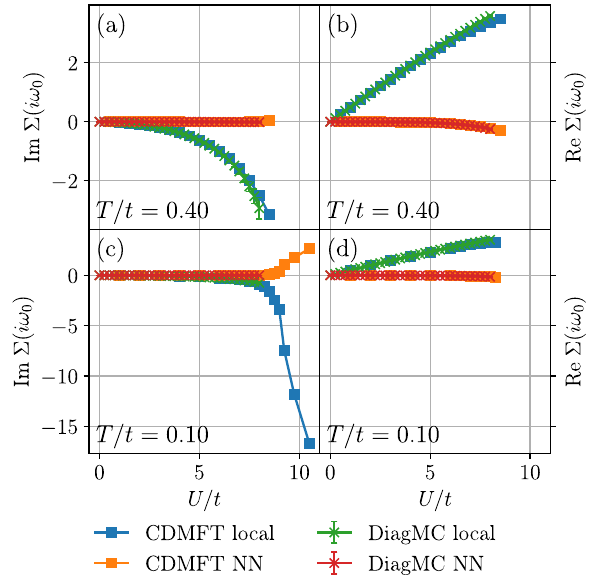
results.FIG. 4. Imaginary (a,c) and real (b,d) parts of the local (blue) and nearest-neighbor (orange) self-energy at its lowest Matsubara frequency calculated by DiagMC (crosses) and CDMFT (squares) as a function of U=t for two different temperatures T=t ¼ 0 . 4 (a,b) and T=t ¼ 0 . 1 (c,d). A substantial increase of nonlocal correlations is observed at low temperatures, however, at interactions ( U=t ≈ 9 . 25 ) larger than the one of increased local correlations ( U=t ≈ 8